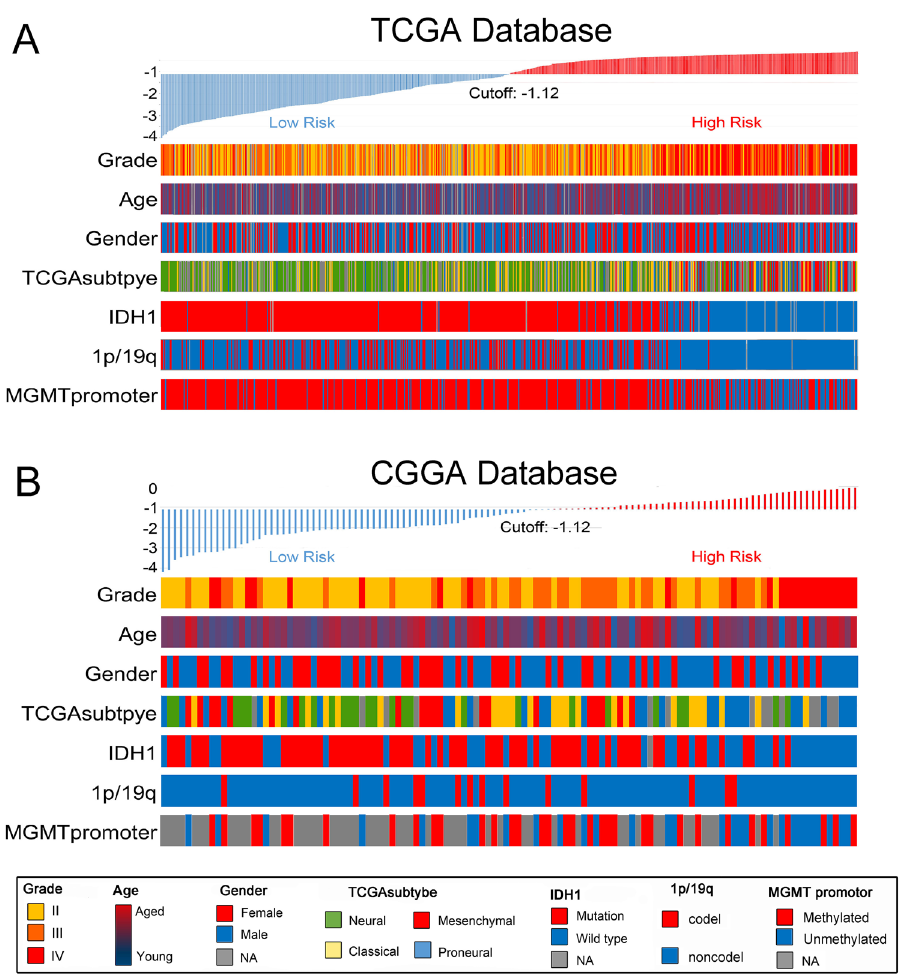
Figure 2. The relationships between risk score and clinical information ( A ) in the TCGA database and ( B ) in the CGGA